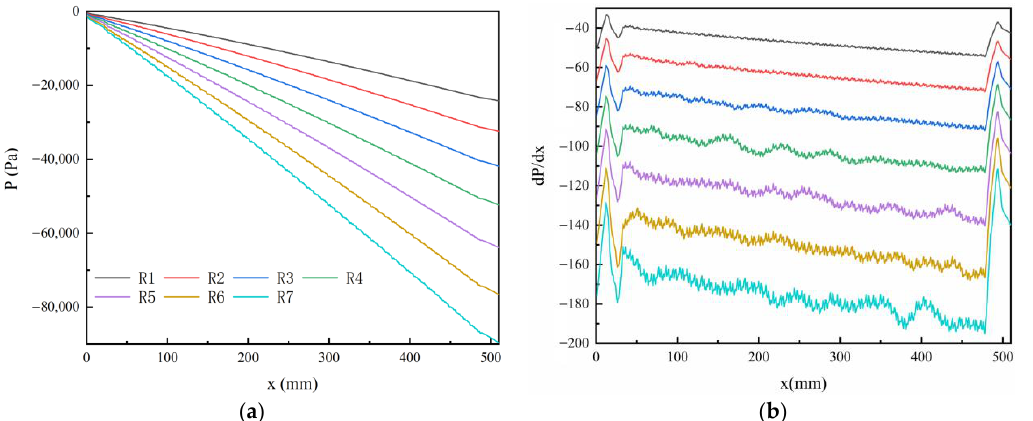
Figure 11. Mean static pressure ( a ) and its partial gradient in the stream-wise component ( b ) for different Reynolds numbers conditions.